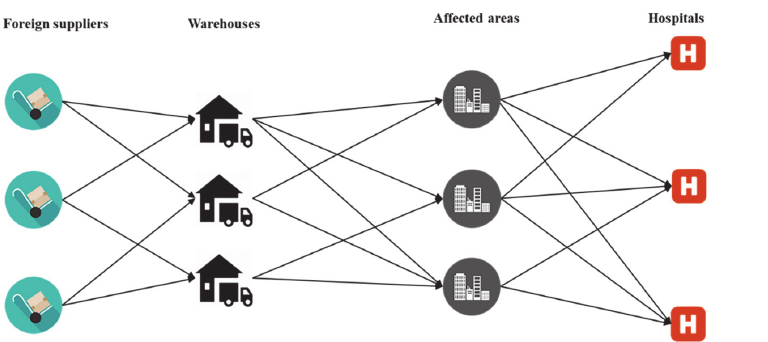
Fig. 1. General schema of humanitarian logistics